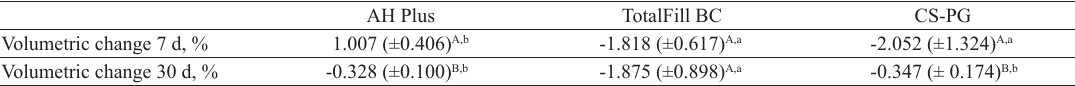
Table 4. Volumetric change (7 and 30 days) (mean and standard deviation) observed in the different endodontic sealers.